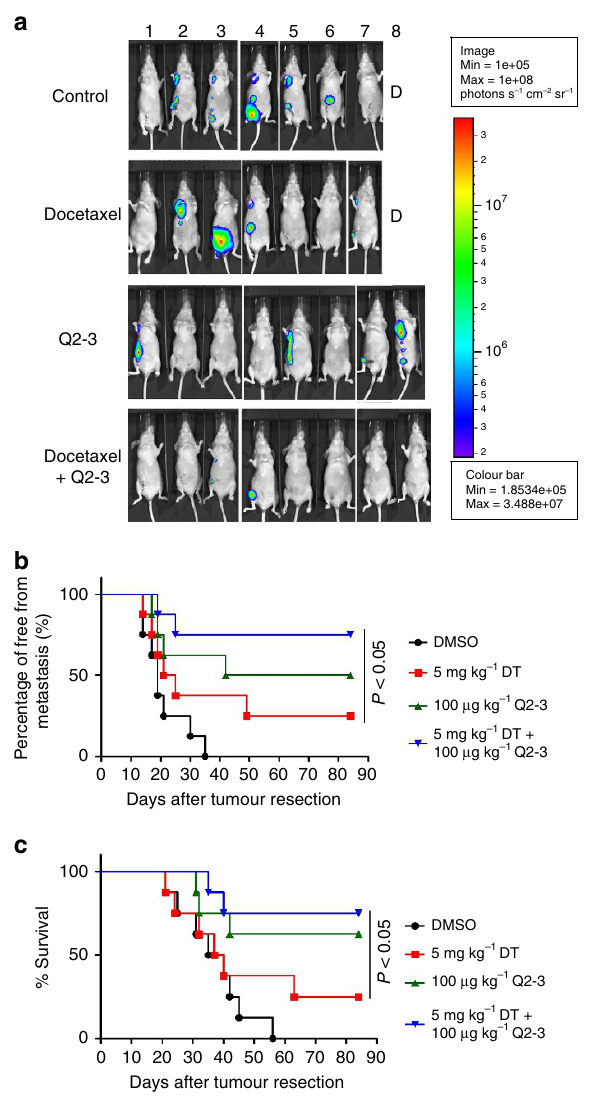
Figure 7 | Q2-3 administration can confer a complementary anti- metastatic effect on human cancer cells (MDA-MB-231), when used in combination with docetaxel. ( a ) Representative bioluminescent images of MDA-MB-231 tumour-bearing nude mice ( n ¼ 8 per group) after in vivo treatment with PBS (0.1% DMSO in saline), Q2-3 (100 m gkg (cid:2) 1 ), docetaxel (5mgkg (cid:2) 1 ) or co-treatment with docetaxel and Q2-3 for 3 weeks, after resection of the orthotopic primary tumours. In PBS-treated (control) and docetaxel-treated groups, one mice was died before 3 weeks post tumour resection. ( b ) Quantification of tumour metastasis by measuring luciferase activity in photonss (cid:2) 1 cm (cid:2) 2 sr (cid:2) 1 in mice revealed along the indicated time course. ( c ) Survival of test mice after different treatments. P o 0.05, were obtained between the docetaxel- and co-treated mice (Kaplan–Meier results were analysed by log-rank test). Similar results were obtained from two or three independent